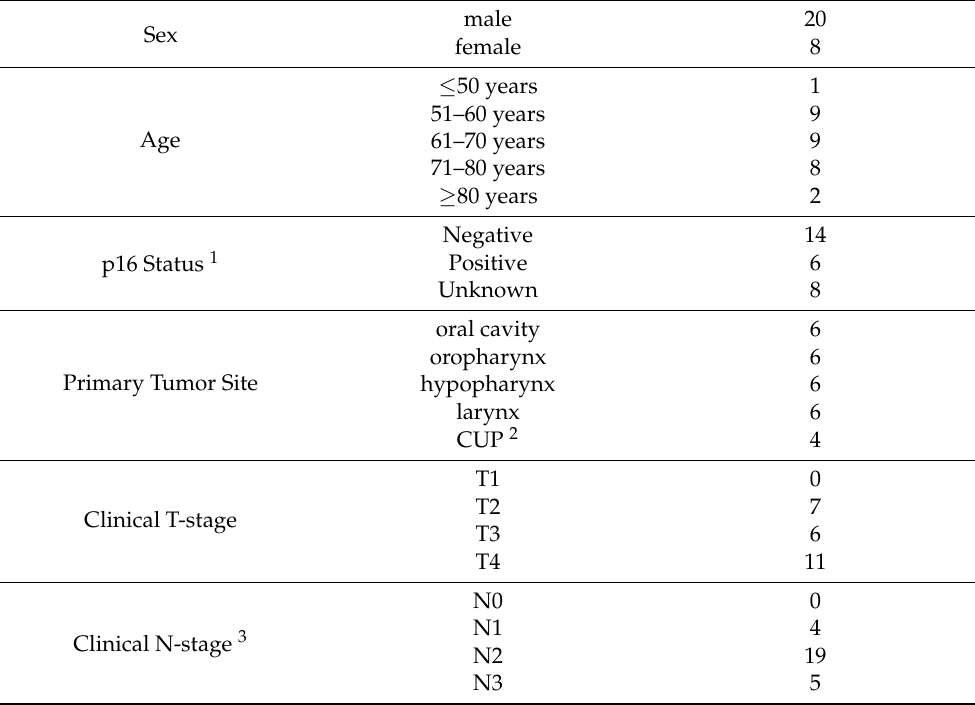
Table 1. Clinical characteristics of the 28 included